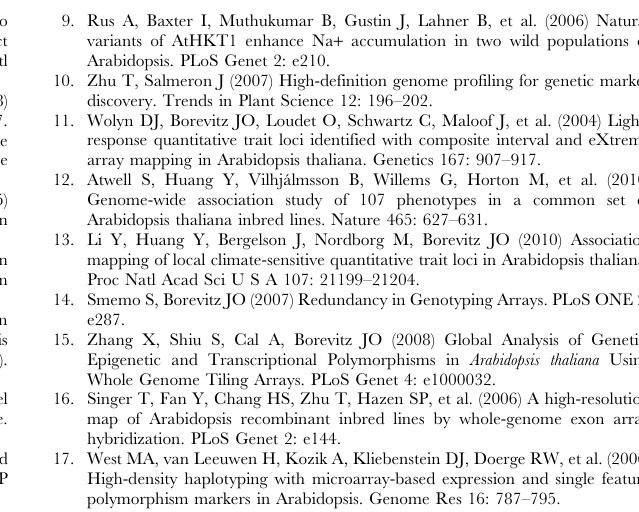
between the Col-0 and Kr-0 parent arrays for probe sets marked by the Atwell et al. [12] as polymorphic (markers) and not marked as polymorphic (controls). (Bottom) Histograms of the allele signals from the parent arrays and the pseudo-F 1 array constructed from the mean of the parent arrays. Figure S2 Eden-1, antisense probe distributions. (Top) Histograms of the antisense probe-wise difference in allele signals between the Col-0 and Eden-1 parent arrays for probe sets marked by the Atwell et al. [12] as polymorphic (markers) and not marked as polymorphic (controls). (Bottom) Histograms of the allele signals from the parent arrays and the pseudo-F 1 array constructed from the mean of the parent arrays. Figure S3 Eden-1, sense probe distributions. (Top) Histograms of the sense probe-wise difference in allele signals between the Col-0 and Eden-1 parent arrays for probe sets marked by the Atwell et al. [12] as polymorphic (markers) and not marked as polymorphic (controls). (Bottom) Histograms of the allele signals from the parent arrays and the pseudo-F 1 array constructed from the mean of the parent arrays. Figure S4 Van-0, antisense probe distributions. (Top) Histograms of the antisense probe-wise difference in allele signals between the Col-0 and Van-0 parent arrays for probe sets marked by the Atwell et al. [12] as polymorphic (markers) and not marked as polymorphic (controls). (Bottom) Histograms of the allele signals from the parent arrays and the pseudo-F 1 array constructed from the mean of the parent arrays. Figure S5 Van-0, sense probe distributions. (Top) Histo- grams of the sense probe-wise difference in allele signals between the Col-0 and Van-0 parent arrays for probe sets marked by the Atwell et al. [12] as polymorphic (markers) and not marked as polymorphic (controls). (Bottom) Histograms of the allele signals from the parent arrays and the pseudo-F 1 array constructed from the mean of the parent arrays.